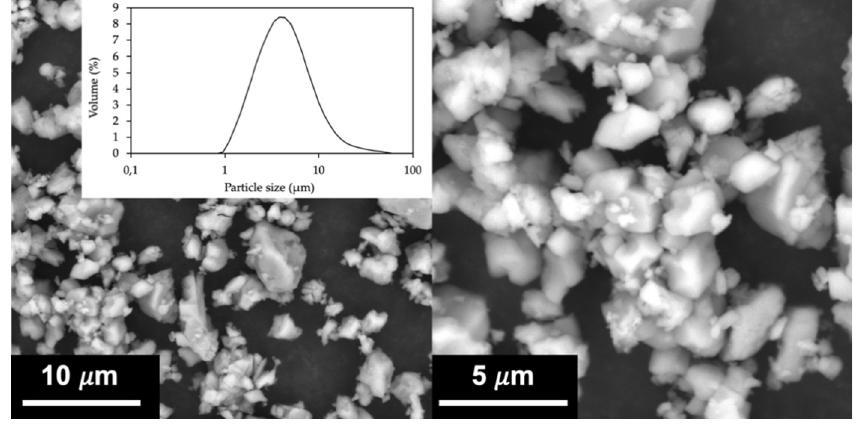
Figure 1. Scanning electron microscopy (SEM) micrographs and corresponding particle size distribution of calcium carbonate (mean, n = 6).